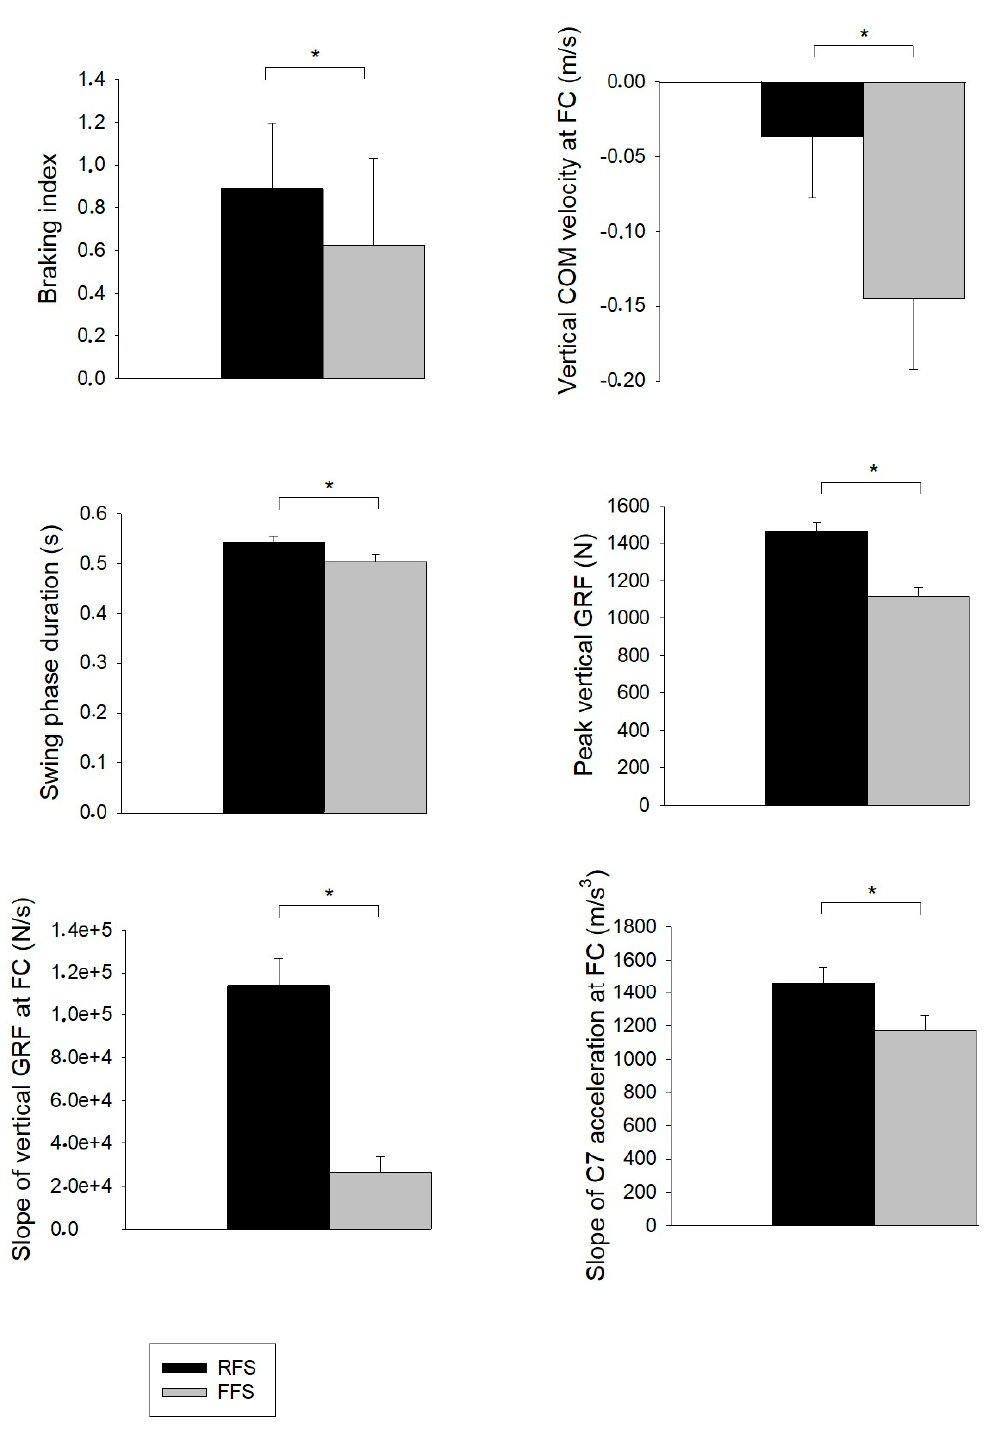
Figure 6. E ff ects of swing-foot strike pattern on collision force parameters, vertical force braking and swing duration. Reported are mean values (all participants together) ± 1 SE. GRF: ground reaction forces; COM: centre of mass; C7: 7th cervical vertebrae; FC: foot contact; RFS: rearfoot strike condition; FFS: forefoot strike condition. * Indicates a significant di ff erence between